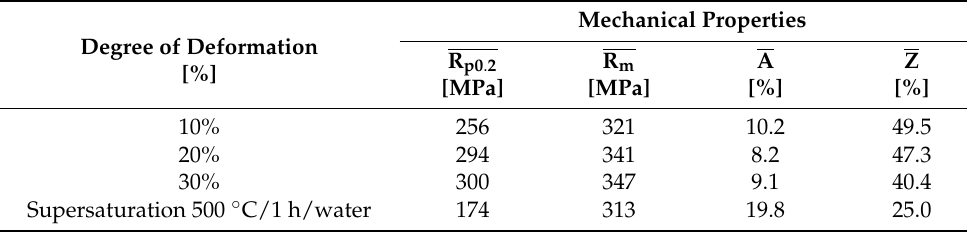
Table 2. Mechanical properties of the investigated alloy after the low-temperature thermomechanical treatment.